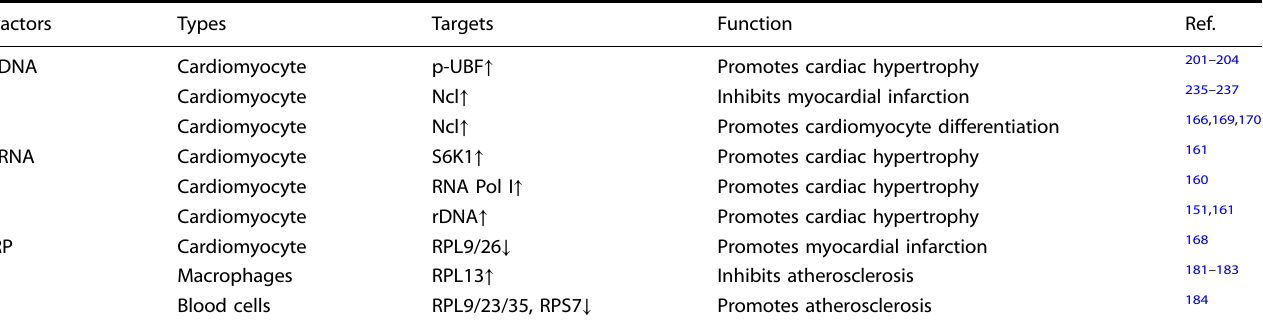
Table 1. Ribosome-related factors and